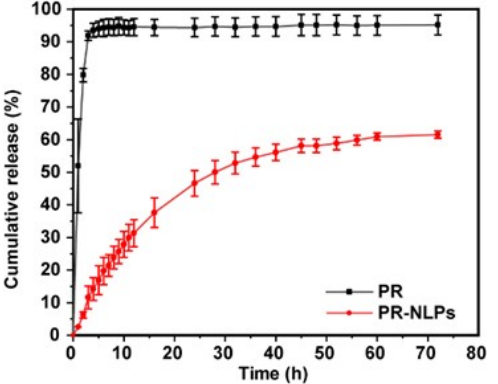
Figure 6. In vitro release profiles of PR and PR-NLPs. Each value is expressed as mean value ± SD ( n =